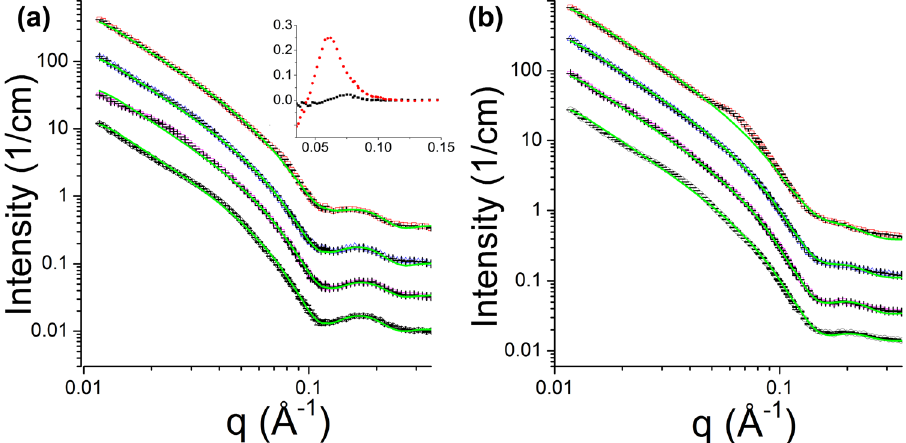
Figure 5. Model fitting results (green) overlaid with experimental data (from bottom to top: no peptide, P/L = 1/100, 1/30, 1/10). ( a ) d54-DMPC: DMPG = 0.75:0.25, ( b ) d54-DMPC: DMPG = 0.5:0.5. Curves are offset for clarity. The inset are subtractions of the model fitting curves from the experimental curves showing the humps in P/L = 1/10 samples (black: d54-DMPC: DMPG = 0.75:0.25, red: d54-DMPC: DMPG =